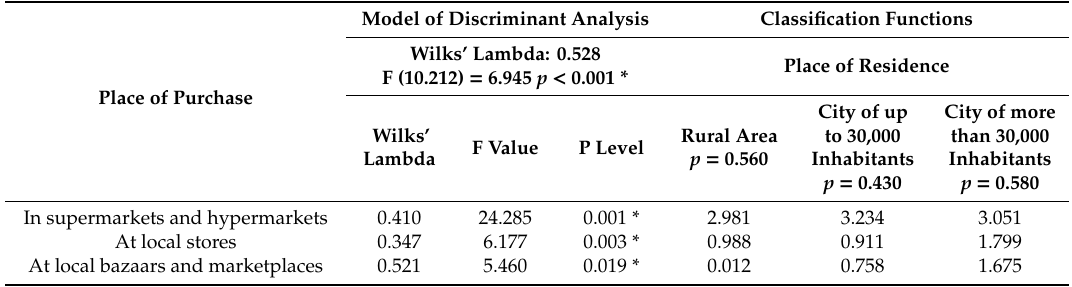
Table 4. Place of purchase of legume products according to the place of residence of the